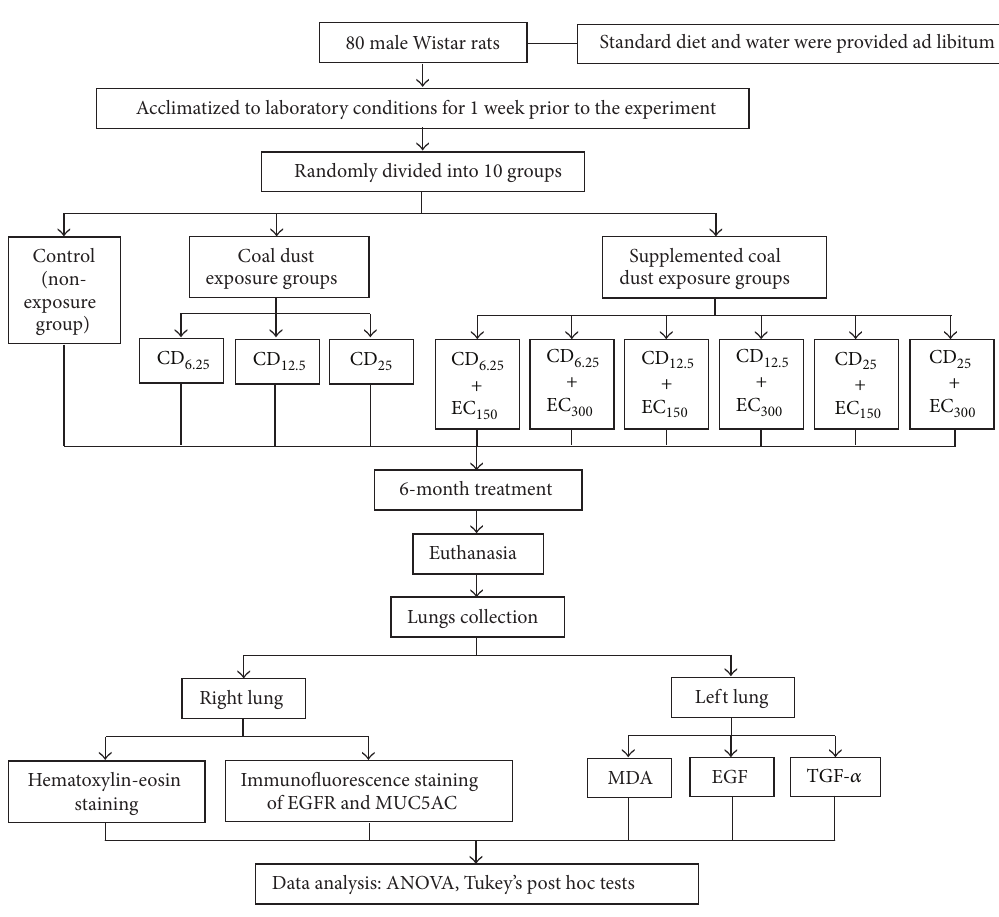
Figure 1: The schematic design of this study. Eighty male Wistar rats were randomly divided into ten groups. One group is a non-exposure group (control). Three groups were exposed to PM 10 coal dust at doses of 6.25 (CD 6.25 ), 12.5 (CD 12.5 ), or 25mg/m 3 (CD 25 ) an hour daily for 6 months. Six groups were exposed to coal dust with concomitant oral administration of Eucheuma cottonii at doses of 150 (EC 150 ) or 300 mg/kgBW (EC 300